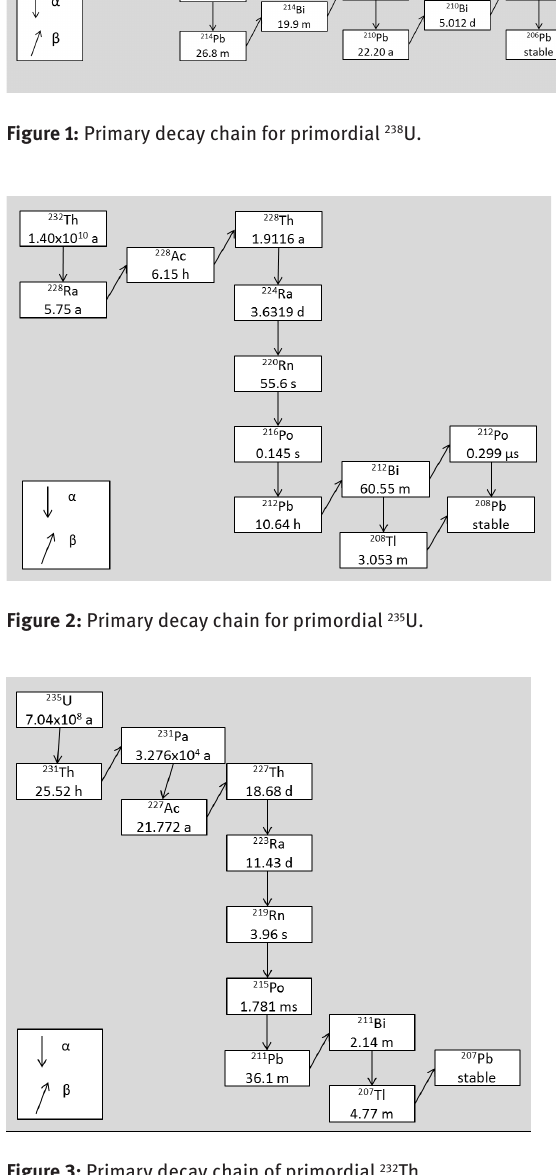
Figure 3: Primary decay chain of primordial 232